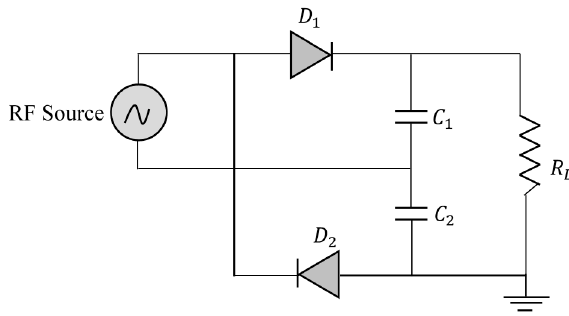
Figure 13. Used rectifier topology.